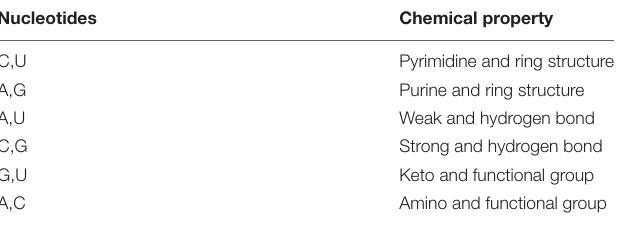
TABLE 1 | ACGU categories based on chemical